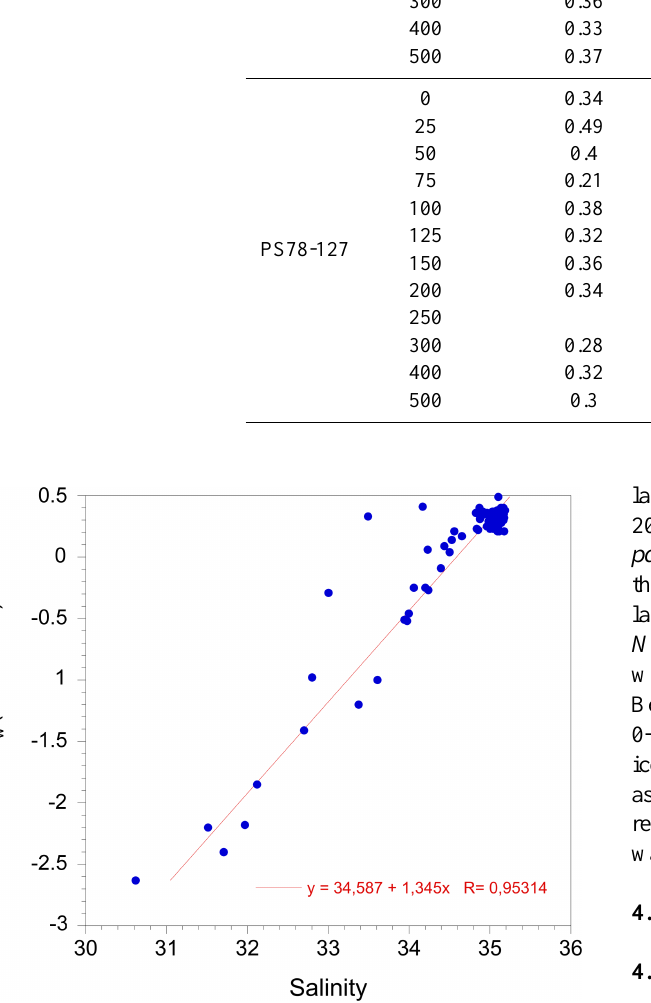
Figure 3. δ 18 O (‰ SMOW) values of the upper 500m of the water column vs. salinities (PSU) for the sampled transect at 78 ◦ 50 (cid:48) N across the Fram